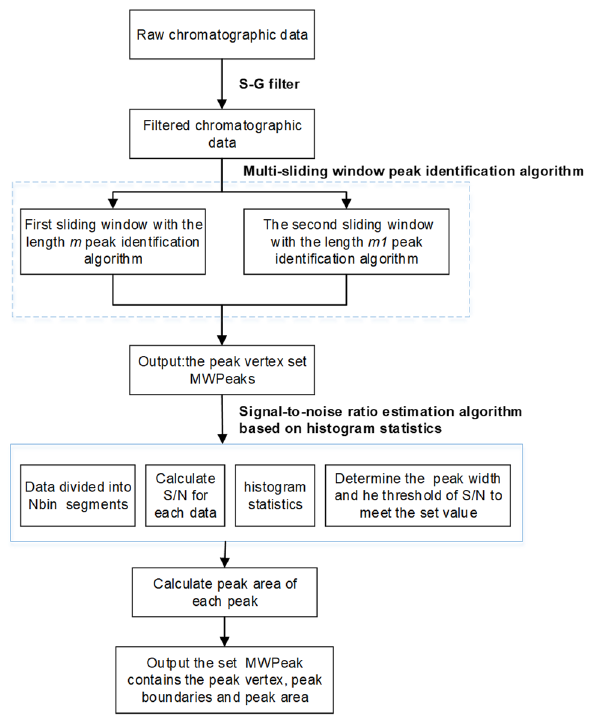
Figure 3. The data process of the multi-window-based signal-to-noise ratio estimation algorithm. At last, the algorithm calculates the peak area of each peak by Equation (11) for quantitative analysis. We define the peak area as S peak = S all − S H , S all , which can be approximated as the number of trapezoidal areas.